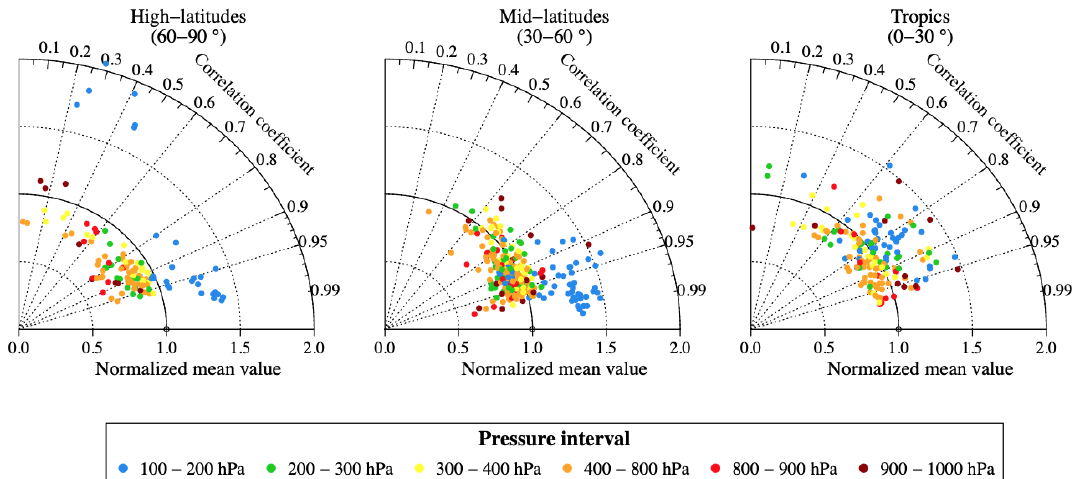
Figure 1. Taylor diagram comparing the mean and temporal correlation of ozone volume mixing ratio between ozonesonde climatology over the 1995–2011 period (Tilmes et al., 2012) and LMDZ-INCA model results, interpolated to the sample locations and vertical levels for high latitudes (60–90 ◦ ), mid-latitudes (30–60 ◦ ) and tropical (0–30 ◦ ) stations. The colours correspond to different pressure ranges, each including different pressure levels (100–200hPa: 3 levels; 200–300hPa: 2 levels; 300–400hPa: 2 levels; 400–800hPa: 5 levels; 800–900hPa: 2 levels; 900–1000hPa: 2